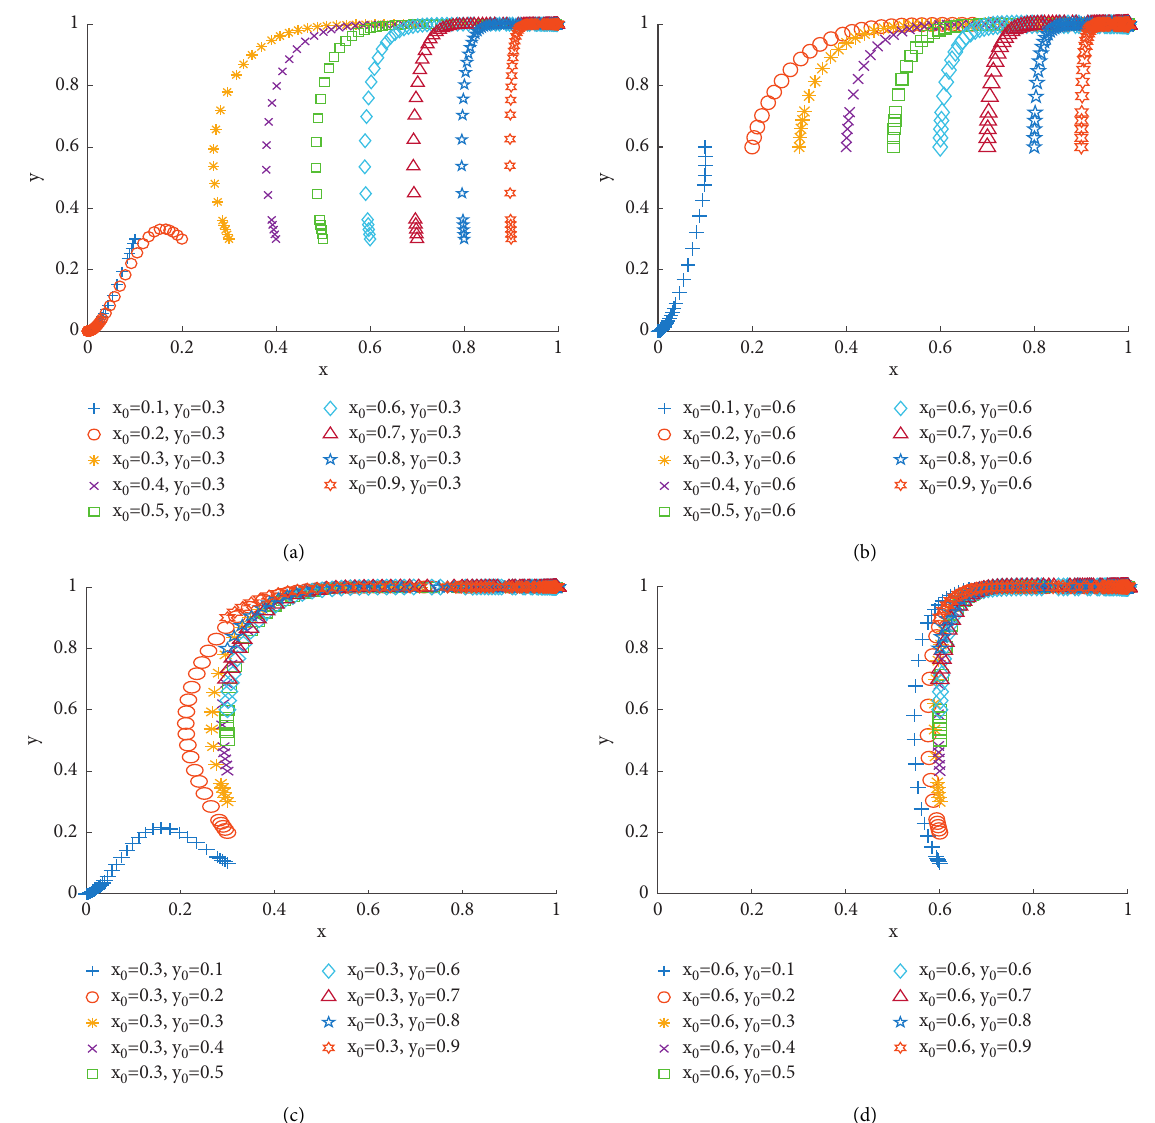
Figure 3: Diagram on the impact of different initial strategies. (a) y